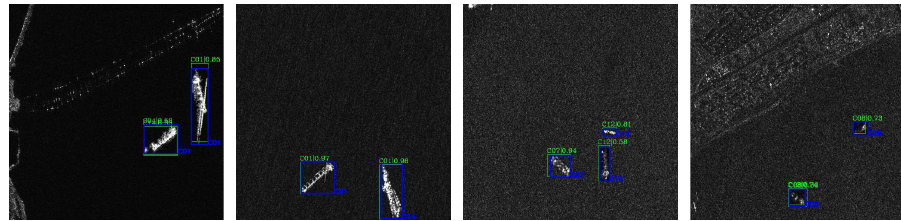
Figure 9. Typical failure detection results. The first two columns and the last two columns present the results for base classes and novel classes,